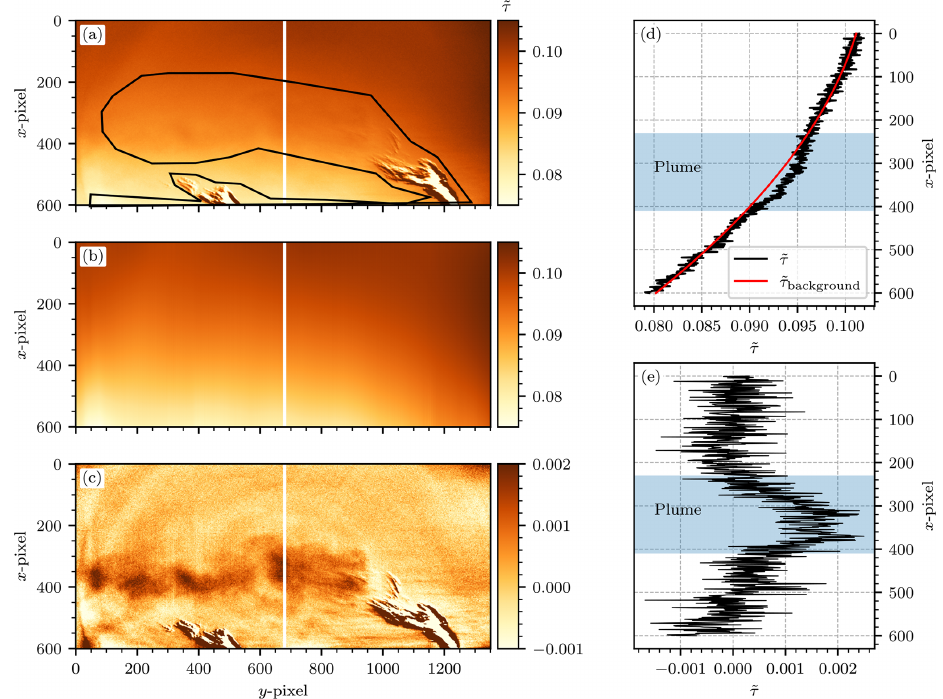
Figure 12. (a) Camera image of the GKM measurement (26 April 2021) without subtraction of the background fit. The plume signal is faintly visible between x = 200 and x = 400. The black outline shows our manual definition of the in-plume region. (b) The background fit to the resulting off-plume region extrapolated to the entire image. A polynomial of degree n = 2 was used as the fit function. (c) The instrument signal image obtained upon subtraction of the background fit. The plume signal is now clearly visible. (d) A plot along the vertical plume cross sections of (a) and (b) , indicated by the white vertical lines at y = 660. The black line shows the original instrument signal ˜ τ along that vertical line without subtraction of the background fit. The red line shows the background signal obtained via the fit routine along that vertical line. (e) A plot along the vertical plume cross section at y = 660 of (c) , which demonstrates that the plume signal becomes visible in the residual upon subtraction of the background